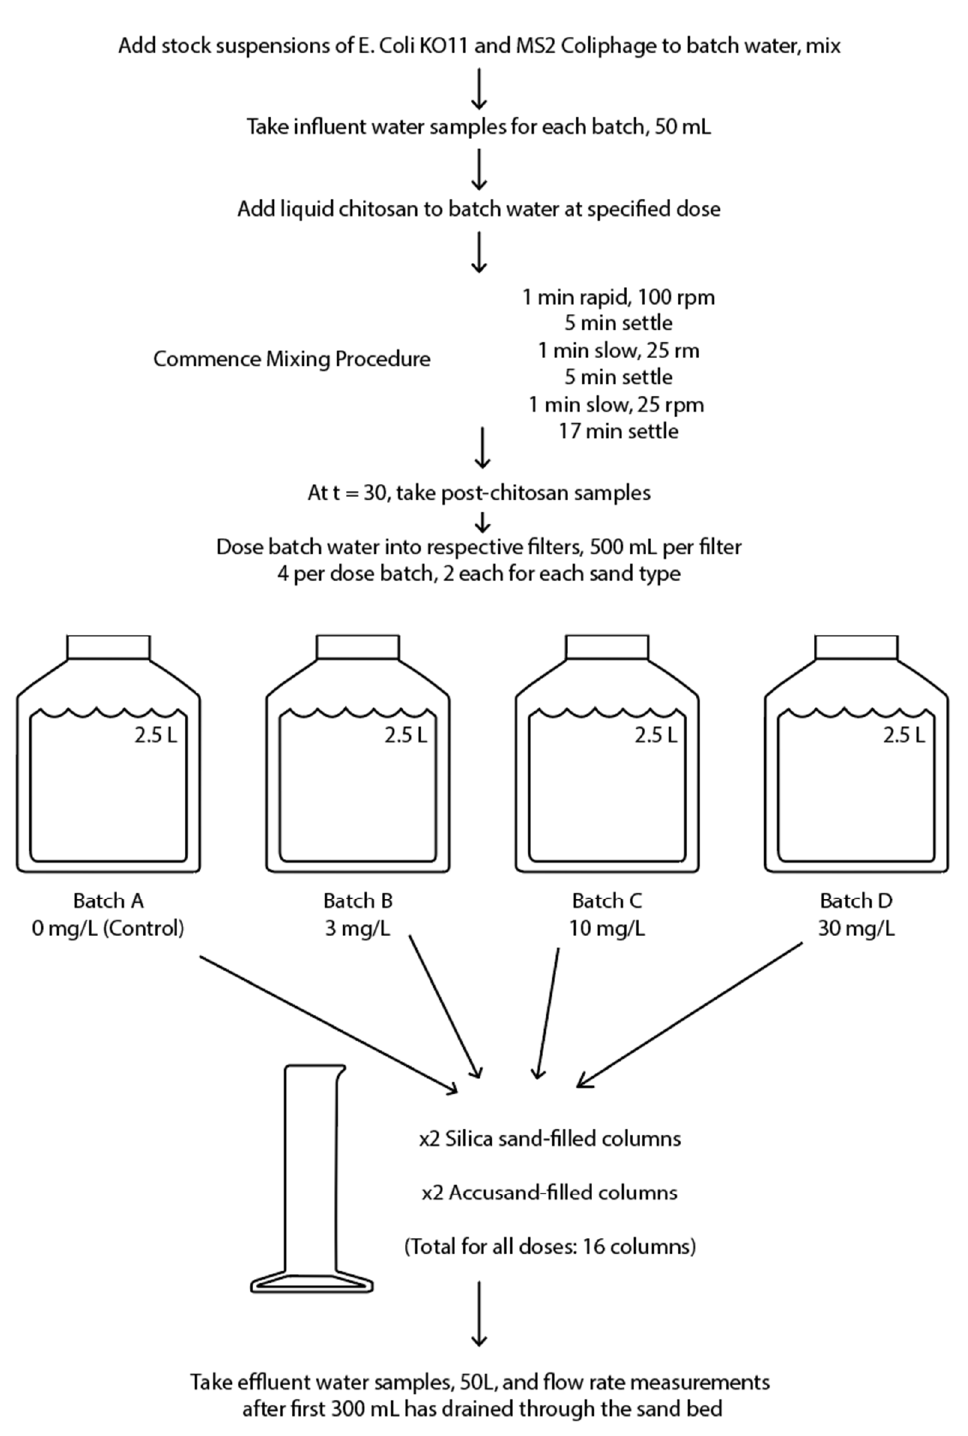
Figure 4. Experimental design for batch water preparation and dosing into sand filters. Test waters were spiked with E. coli KO11 (ATCC# 55124) and male-specific (F+) coliphage (bacteriophage) MS2 (ATCC# 15597-B1). Microbial stocks were prepared to achieve at least a 6 log 10 per 100 mL spiking concentrations in test water so that reductions of 99.9999% or 6 log 10 could be quantified. A one mL volume of frozen suspension of over- night logarithmic phase growth culture of E. coli KO11 was added to 200 mL tryptic soy broth (TSB) with 1% V/V chloramphenicol stock solution (100× stock concentration, 3.4